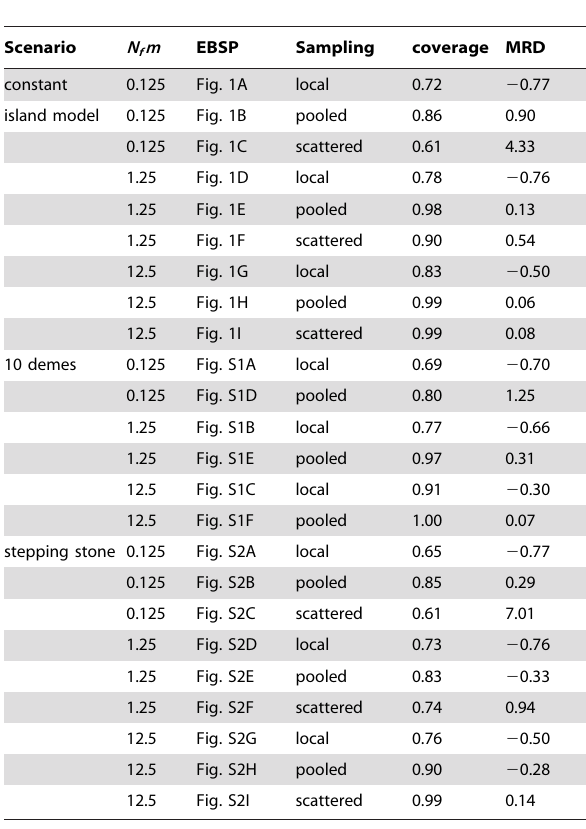
Table 1. Comparison of EBSP and simulated population sizes under different structural scenarios.